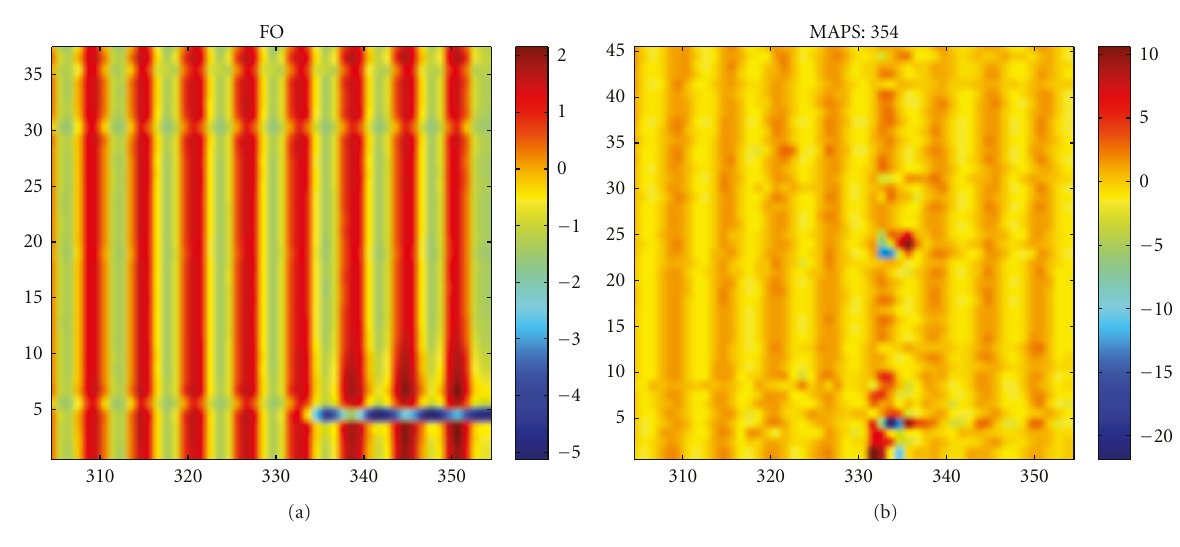
Figure 14: Wire 6 break.